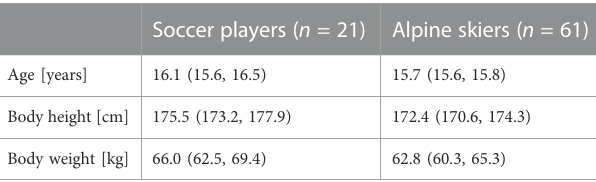
TABLE 1 Baseline characteristics.